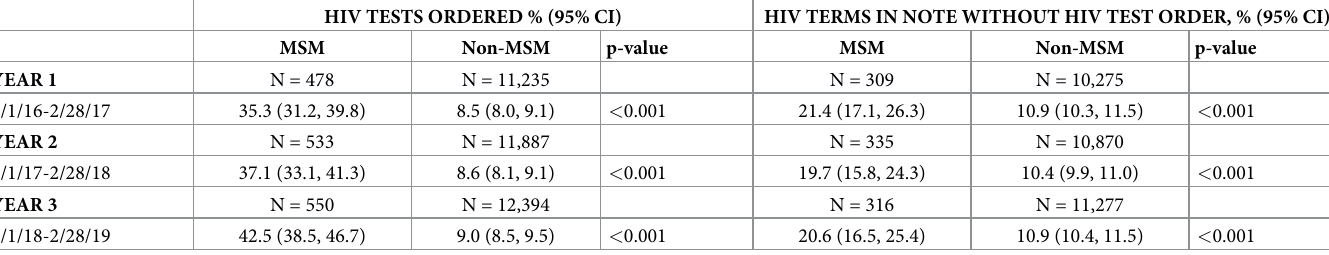
Table 2. Yearly HIV test order rates and noted HIV discussion by MSM vs.